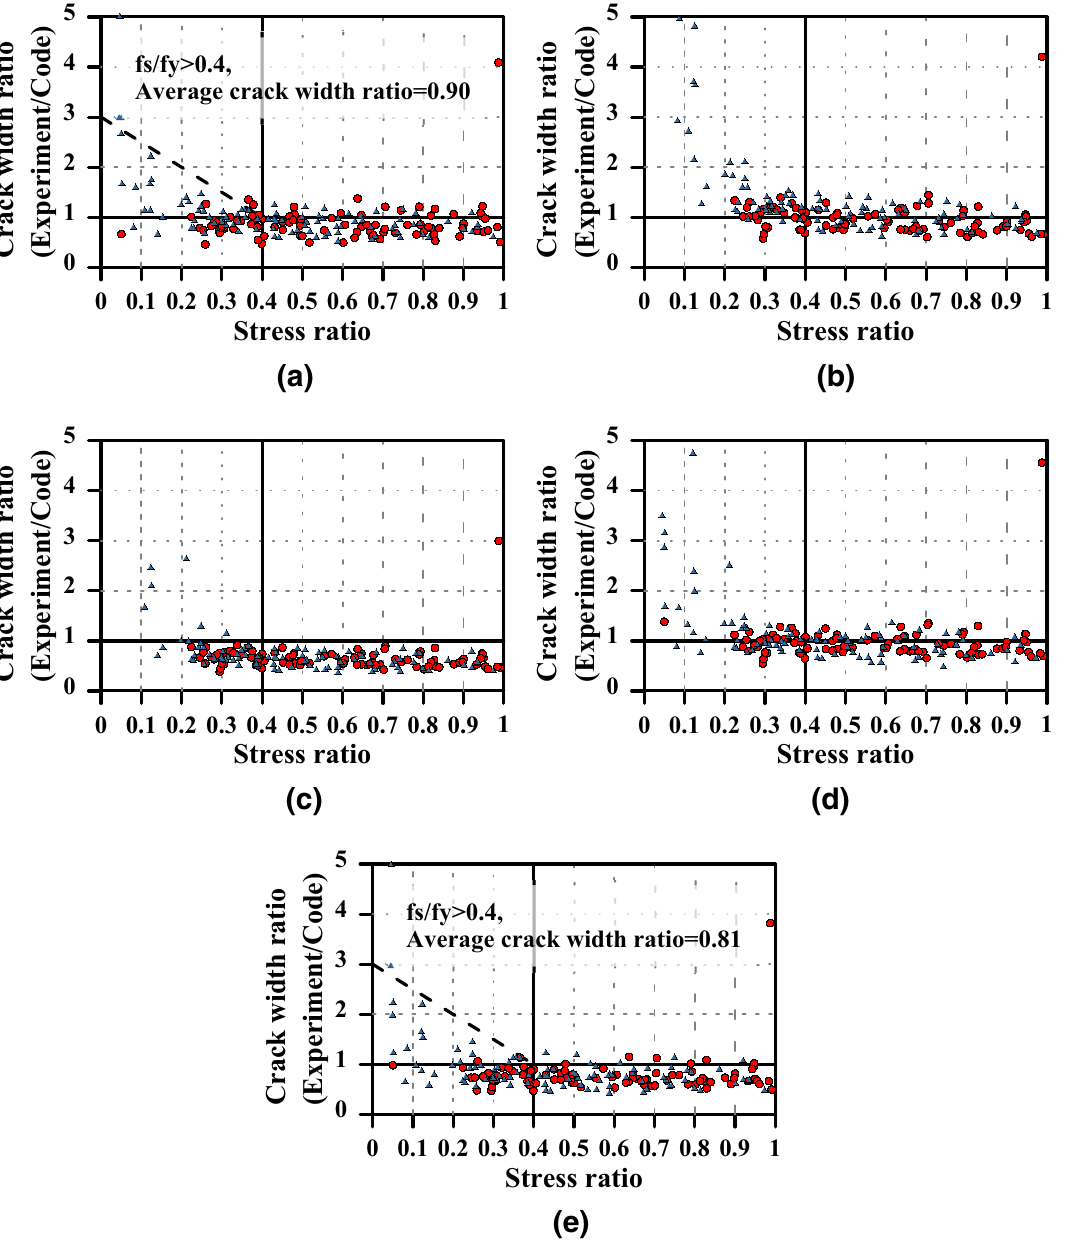
Fig. 18 Ratio of the measured and calculated maximum flexural crack widths under various stress ratios of the tensile reinforcement. a ACI 318 (2014), b CEB-fib (2010), c AIJ (2010), d JSCE (2007), and e ACI 318 (2014) (Modified) (Circle points are the specimens in this work; triangle points are the specimens in the references (Chiu et al. 2014,